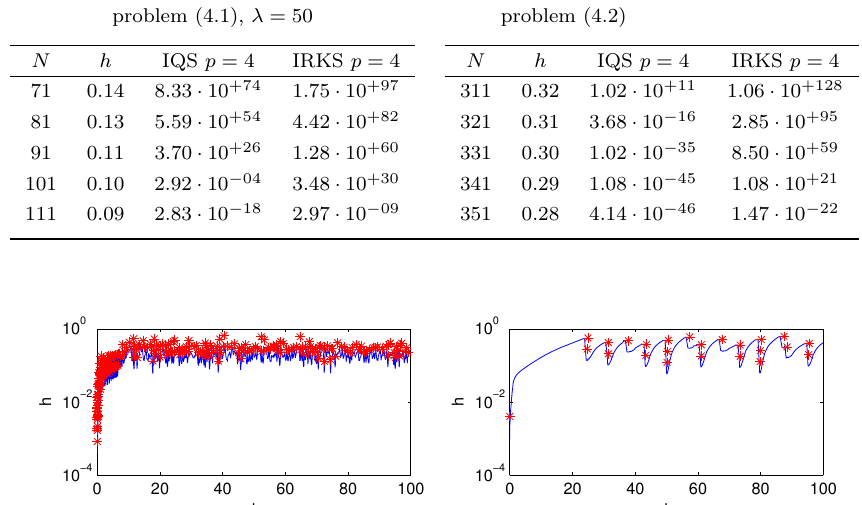
Table 2. Errors of Nordsieck method and IRKS method of order p = 4 for problem (4.1), with T = 10, and problem (4.2), with constant stepsize. problem (4.1), λ = 50